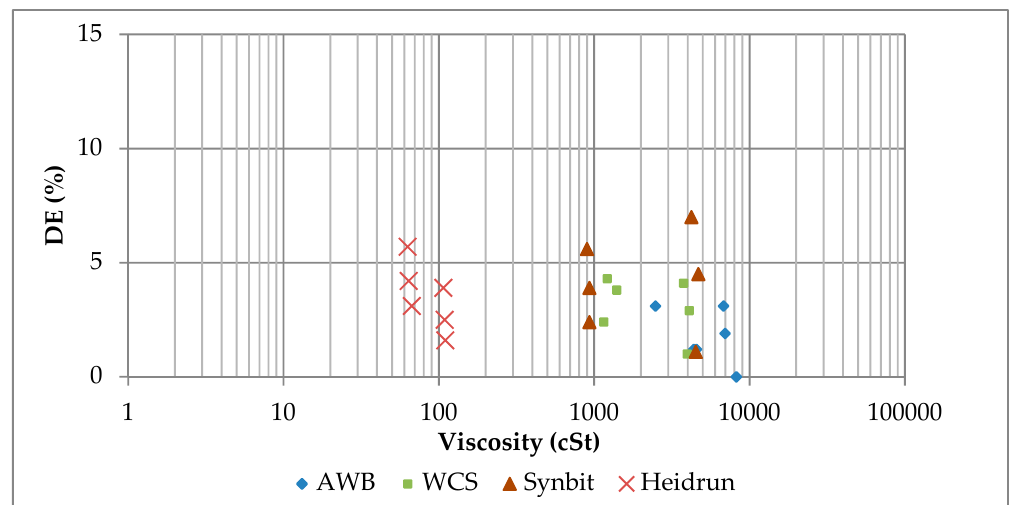
Figure 5. A plot of effectiveness of natural dispersion (DE %) as a function of oil viscosity. Experiments were conducted in spring and summer (Table S1). DE is < 10% for all oils tested.